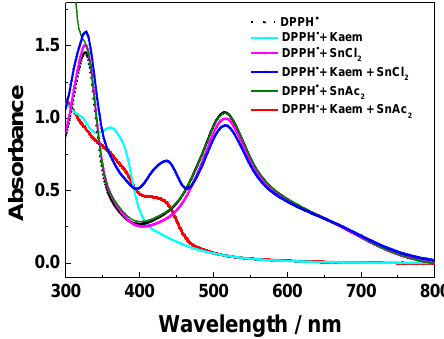
Figure 7. Absorption spectra of 100 µM DPPH • , 100 µM DPPH • plus 100 µM HKaem, 100 µM DPPH • plus 100 µM SnCl 2 /Sn(OAc) 2 , and 100 µM DPPH • plus 100 µM HKaem + 100 µM SnCl 2 /Sn(OAc) 2 . Ethanol was used as the solvent.